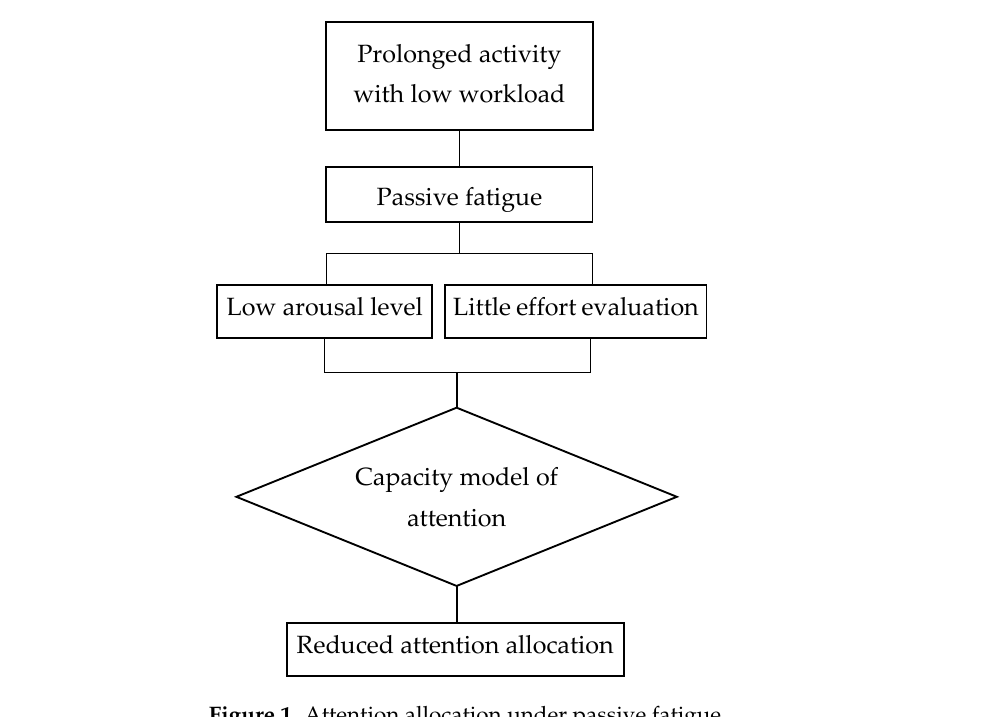
Figure 1. Attention allocation under passive fatigue.